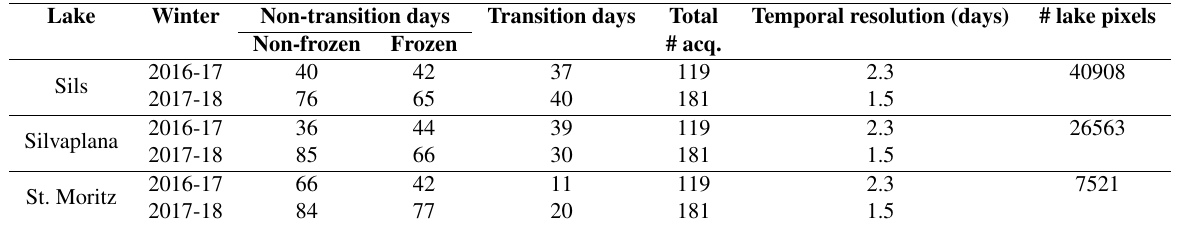
Table 2: Dataset statistics. Non-transition days, on which a lake is almost fully frozen / non-frozen, and transition days (partially frozen) are shown. Lake pixels are those which lie completely inside the lake polygon. # acq. denotes the number of acquisitions. Lake